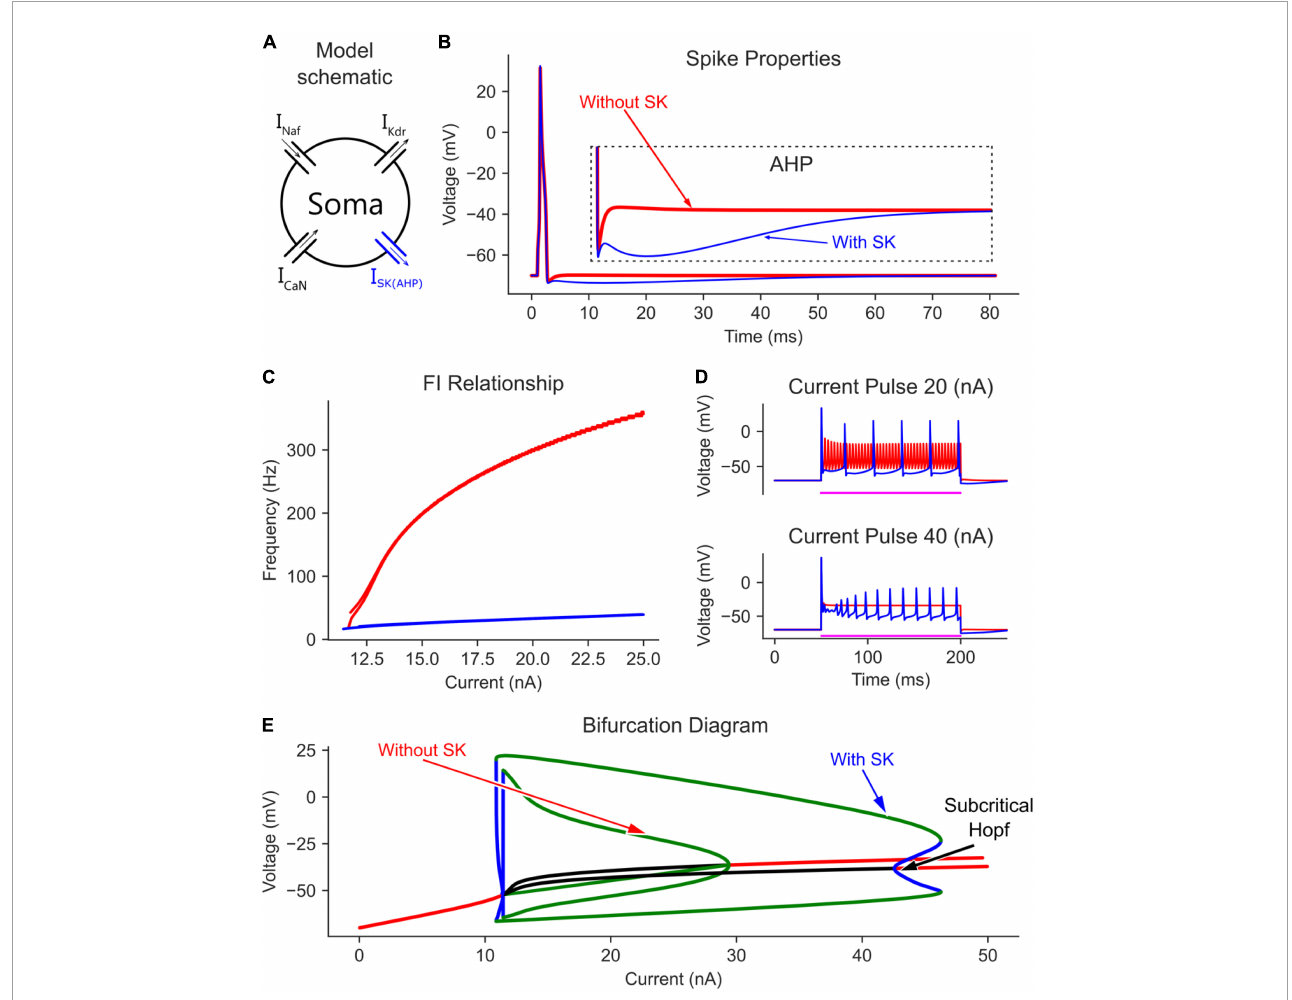
FIGURE3 The effect of somatic SK channels on the MN model bifurcation diagram. (A) The soma model with SK channels added to the Na, K, and CaN channels. The AP and AHP shapes (B) , F-I relationship (C), and MN repetitive firing on long pulses (D) with (blue traces) and without (red traces) the somatic SK channels included in the model. (E) The V-I bifurcation diagram of the MN model with and without the somatic SK channels. In the diagram, the green and blue traces indicate the extrema of the stable and unstable limit cycles, respectively. The red and black traces show stable and unstable equilibrium points,